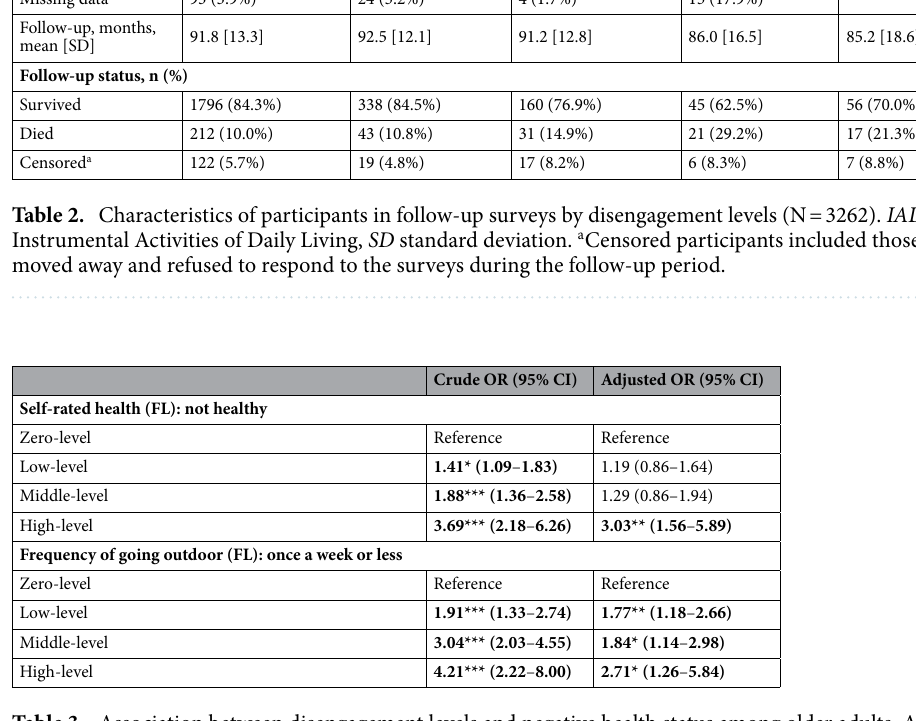
Table 3. Association between disengagement levels and negative health status among older adults. Adjusted for sex, age at follow-up, self-rated health, frequency of going outdoors, chronic disease, instrumental activities of daily living disability, perceived financial status, and living arrangement at baseline. FL follow-up survey, OR odds ratio, CI confidence interval. Bold numbers are statistically significant (* p < 0.05, ** p < 0.01, *** p < 0.001).